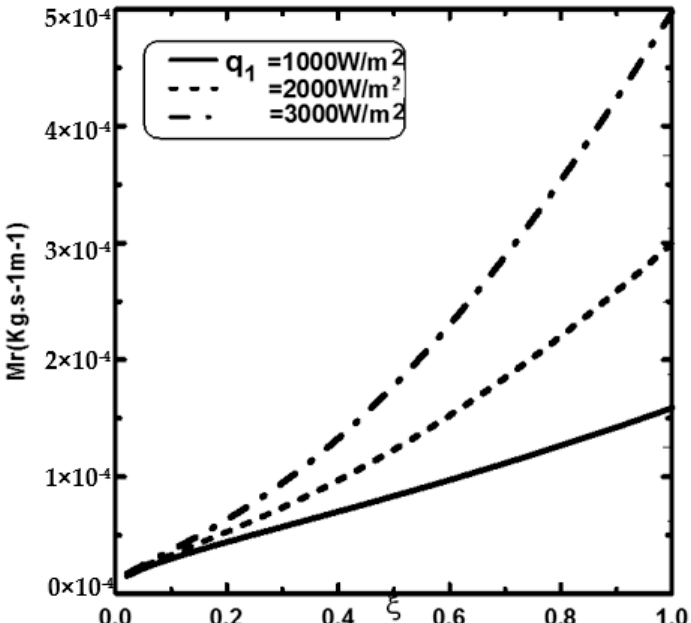
Figure 12. Evolution of the cumulated evaporation rate to various heat flux: T 0L = 293.15 K, T 0 = 293.15 K, u 0 = 1 m/s, T w = 293.15 K, m 0L = 15 × 10 − 4 Kg/m.s, H = 1 m, d = 0.015 m, c 0 = 0, p 0 = 1 atm, φ 0 = 0.03.